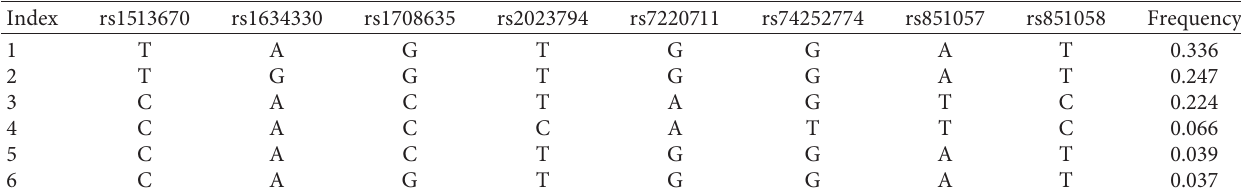
Figure 1: Linkage disequilibrium (LD) patterns for the SOST gene. The pairwise LD values (D’ × 100) of all SNPs are given in each diamond. D’ is calculated as D divided by the theoretical maximum for the observed allele frequencies. Bright red filled diamonds without values indicate a D’ � 1. One block with high LD was identified. Numbers in bracket indicate the length of the block. Table 4: The structure and frequency of SOST haplotypes for all available